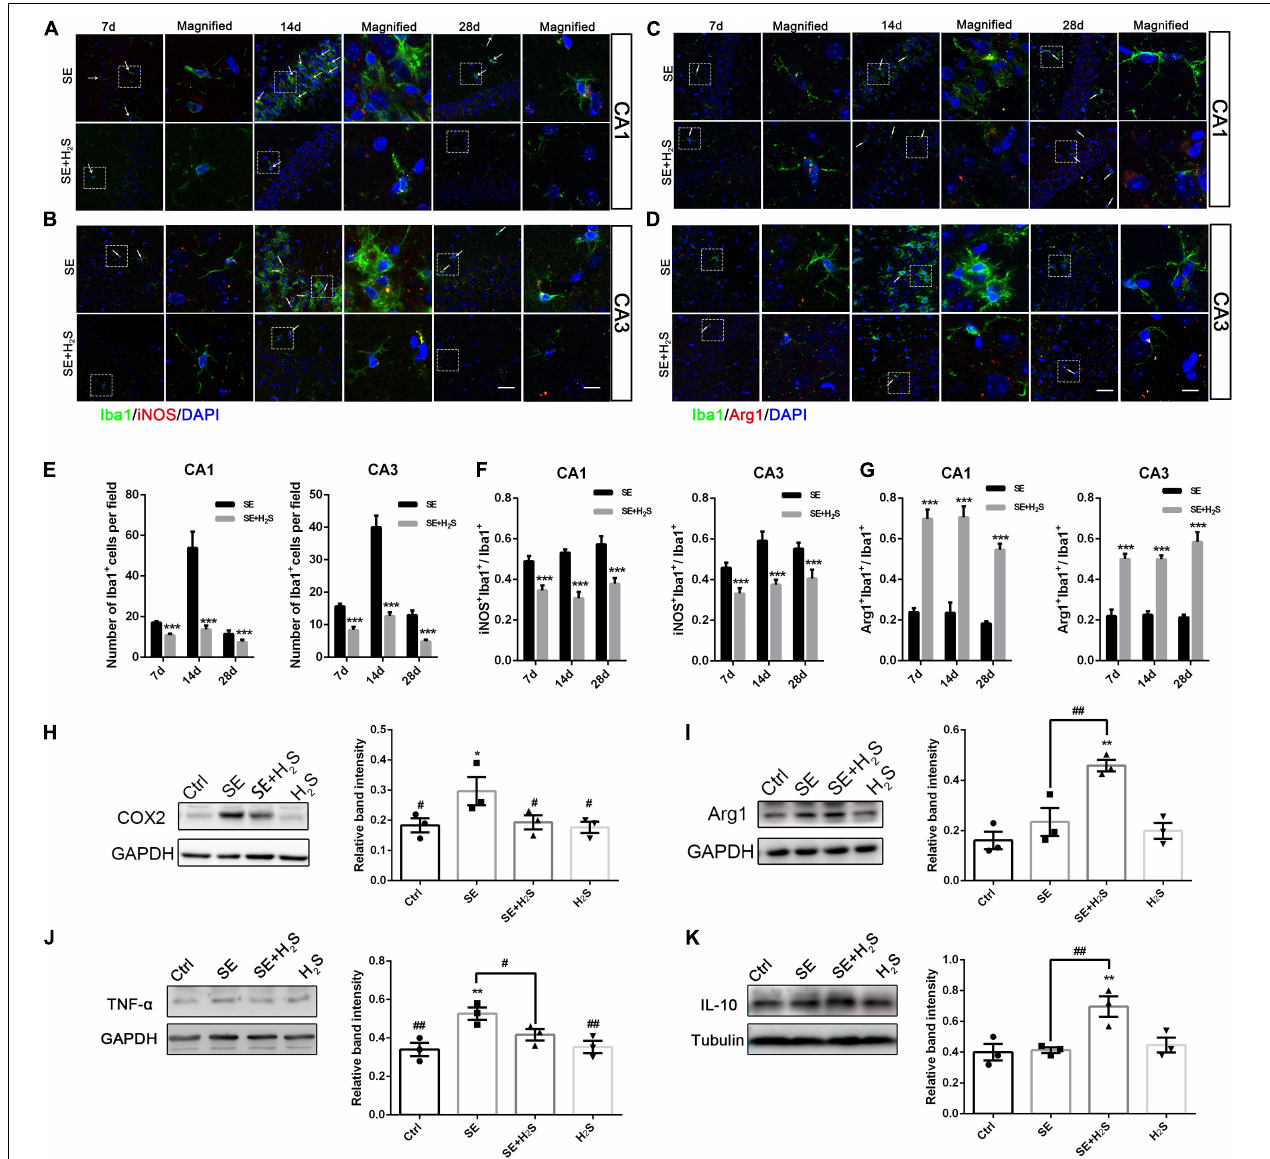
FIGURE 3 | The H 2 S donor downregulated the levels of microglial pro-inflammatory profile in vivo . (A,B) Representative images of iNOS (red) with Iba1 (green) immunostaining or (C,D) Arg1 (red) with Iba1 (green) immunostaining in the CA1 and CA3 regions of the hippocampus in control and the H 2 S donor-treated SE mice. Scale bar 25 µ m in the merged panel and 5 µ m in the magnified panel. Magnified images are expansions of boxed areas in corresponding panels in the left of each magnified image. (E) Quantitative analysis of Iba1 + cells in CA1 and CA3 regions of the hippocampus. (F) Quantitative data are shown the ratio of iNOS + : Iba1 + to total Iba1 + cells. n = 6 per group. *** p < 0.001 vs SE. Two-way ANOVA with Bonferroni post hoc tests. (G) Quantitative data are shown as the ratio of Arg1 + : Iba1 + to total Iba1 + cells. n = 6 per group. *** p < 0.001 vs SE. Student’s t test. (H–K) Western blot assay shows that expression levels of microglial pro-inflammatory markers (COX2 and TNF- α ) are increased in the hippocampus of SE mice. However, the H 2 S donor decreased COX2 and TNF- α expression and increased Arg-1and IL-10 expression in SE mice. The results are expressed as the mean ± SEM. n = 3 per group.* p < 0.05, ** p < 0.01 vs Control, # p < 0.05, ## p < 0.01 vs SE. One-way ANOVA with Bonferroni post hoc tests.